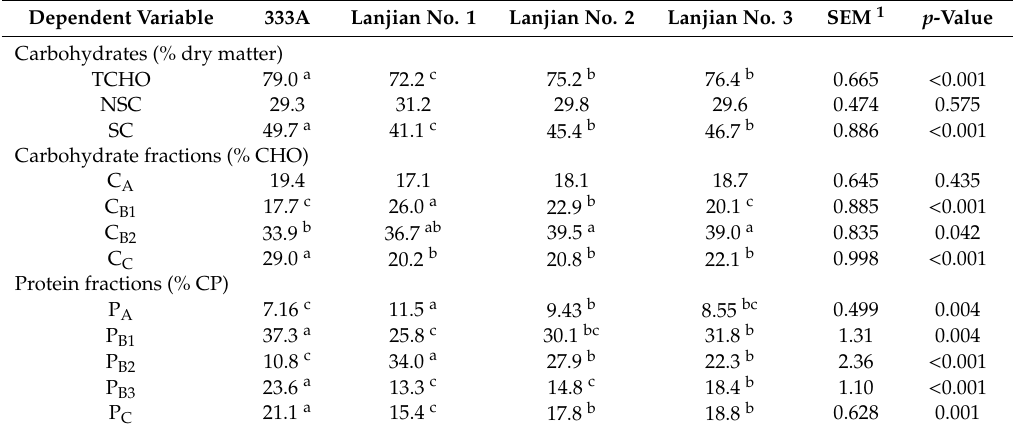
Table 4. Influence of variety on carbohydrate and protein fractions of straw in four common vetch